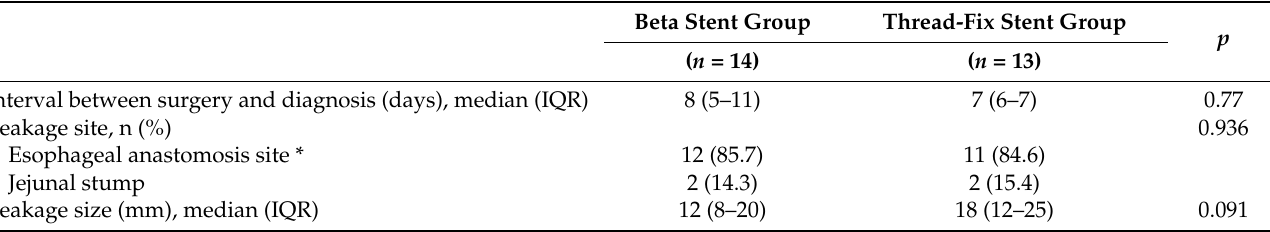
Table 2. Characteristics and managements of anastomotic leakages before stent placement by